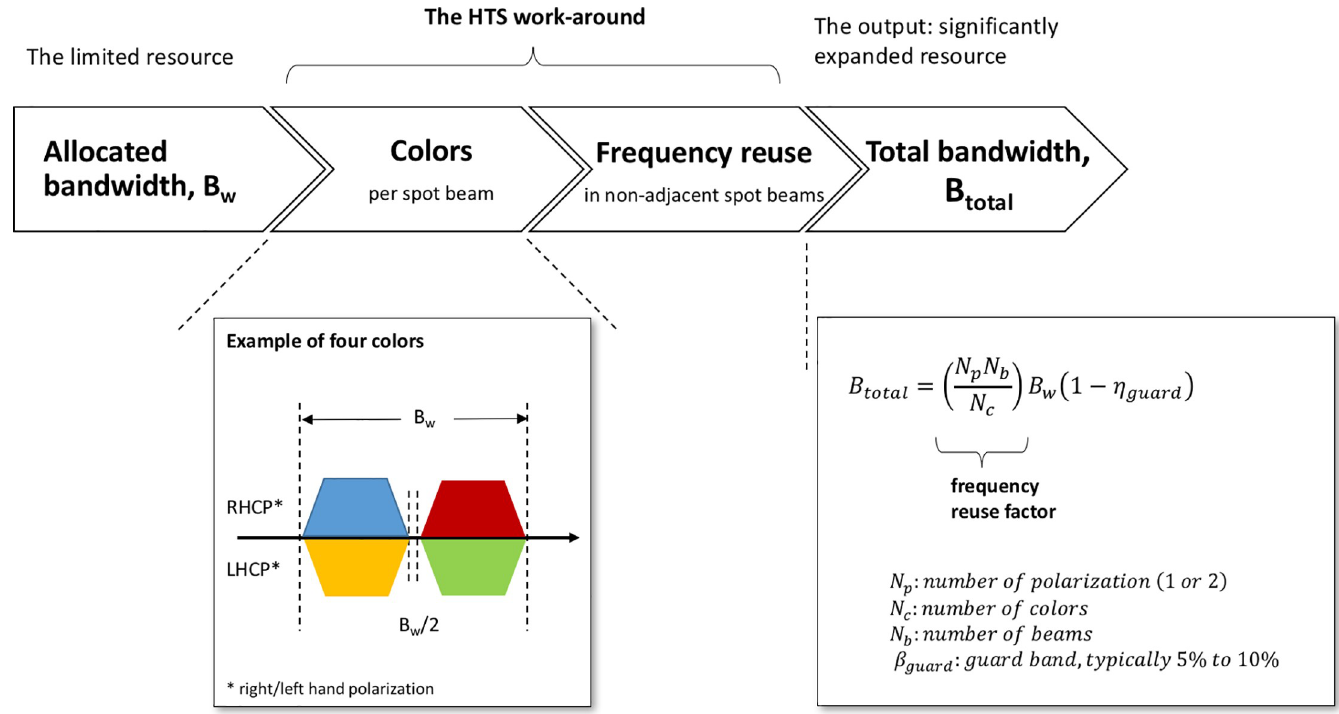
Fig 1. Defining features of hight-throughput